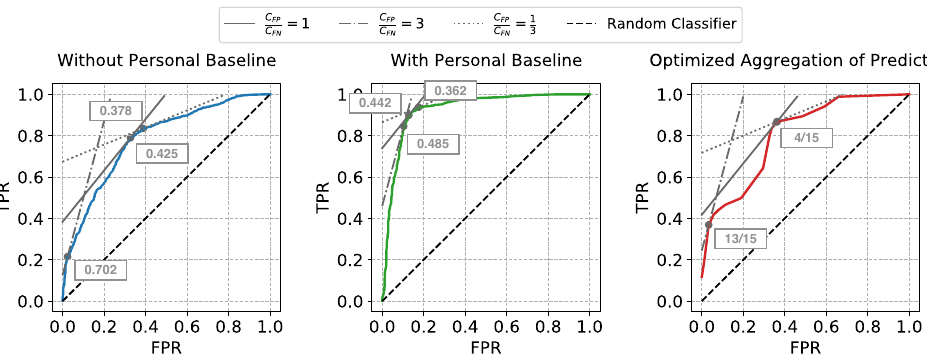
Figure 6. The iso-performance lines and the selected cost-optimal decision thresholds (shown in boxes) corresponding to the three different settings of C FP C FN